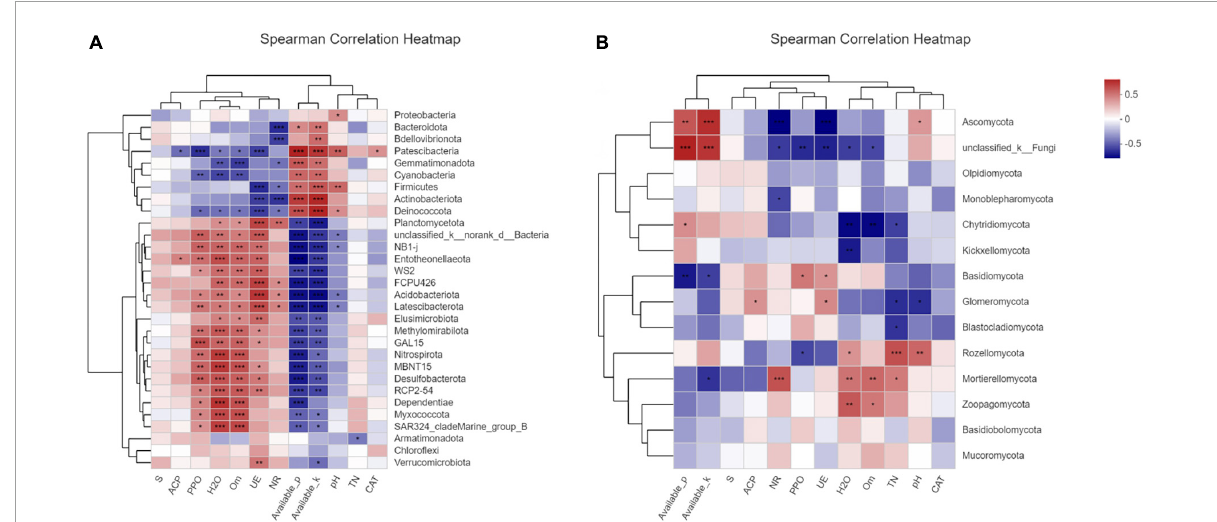
FIGURE6 Correlation heat map was used to analyze the correlation between environmental factors and communities at the phylum level of bacteria (A) or fungi (B) in soil samples, so as to represent the correlation coefficient between each microorganism in the community and environmental factors, thus indicating the relationship between microbial classification and environmental factors. The asterisk indicates a statistically significant t -test analysis. *, **, and *** represent p -values ≤ 0.05, 0.01, and 0.001,